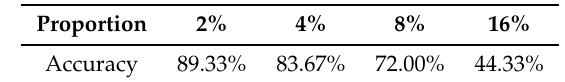
Table 6. Accuracy of each group of noise added